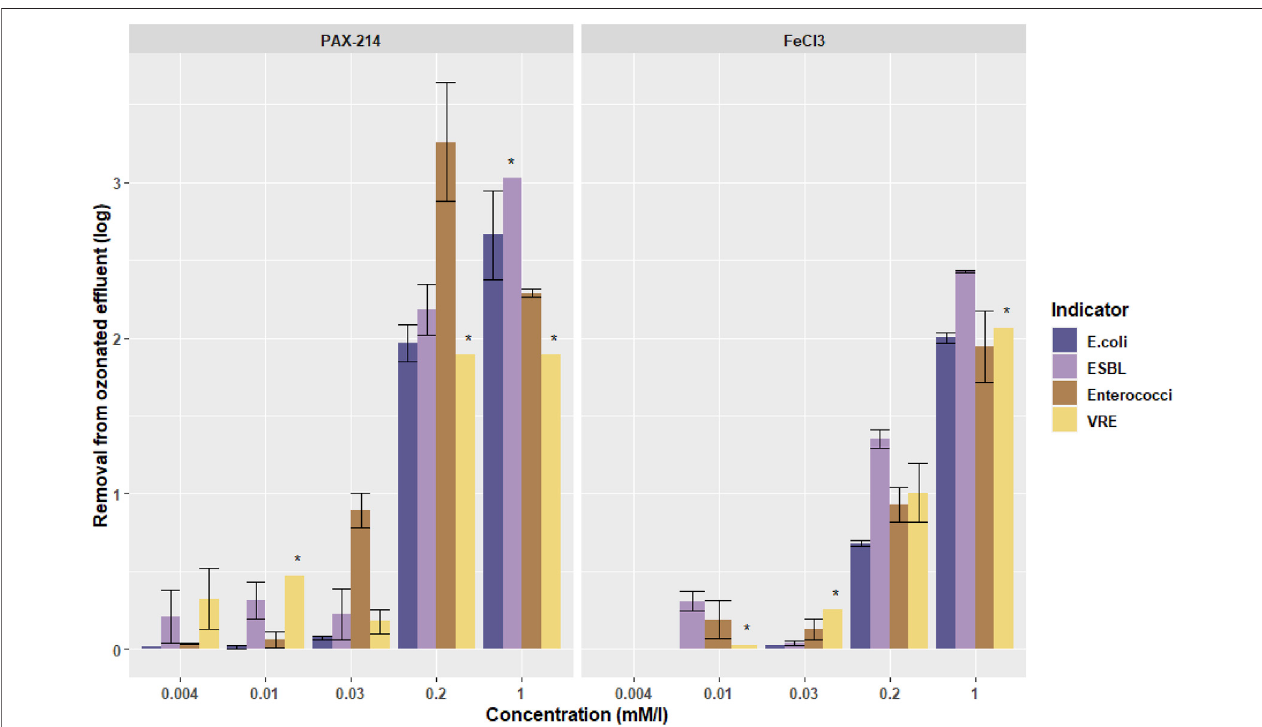
FIGURE4| Thelogremovalofthedifferentindicatorbacteriawithdifferentcoagulants(Aluminum(PAX-214)andIron(FeCl 3 )atdifferentconcentrationsinozonated water from the pilot plant (location B in Figure 2 with 0.4 g O 3 /g DOC). Error bars indicate standard deviation. Bars marked with an * indicate a minimum estimated removal, due to concentrations below the detection limit. The missing bar for E. coli at 0.01 mM/L FeCl 3 represents an absence of removal.